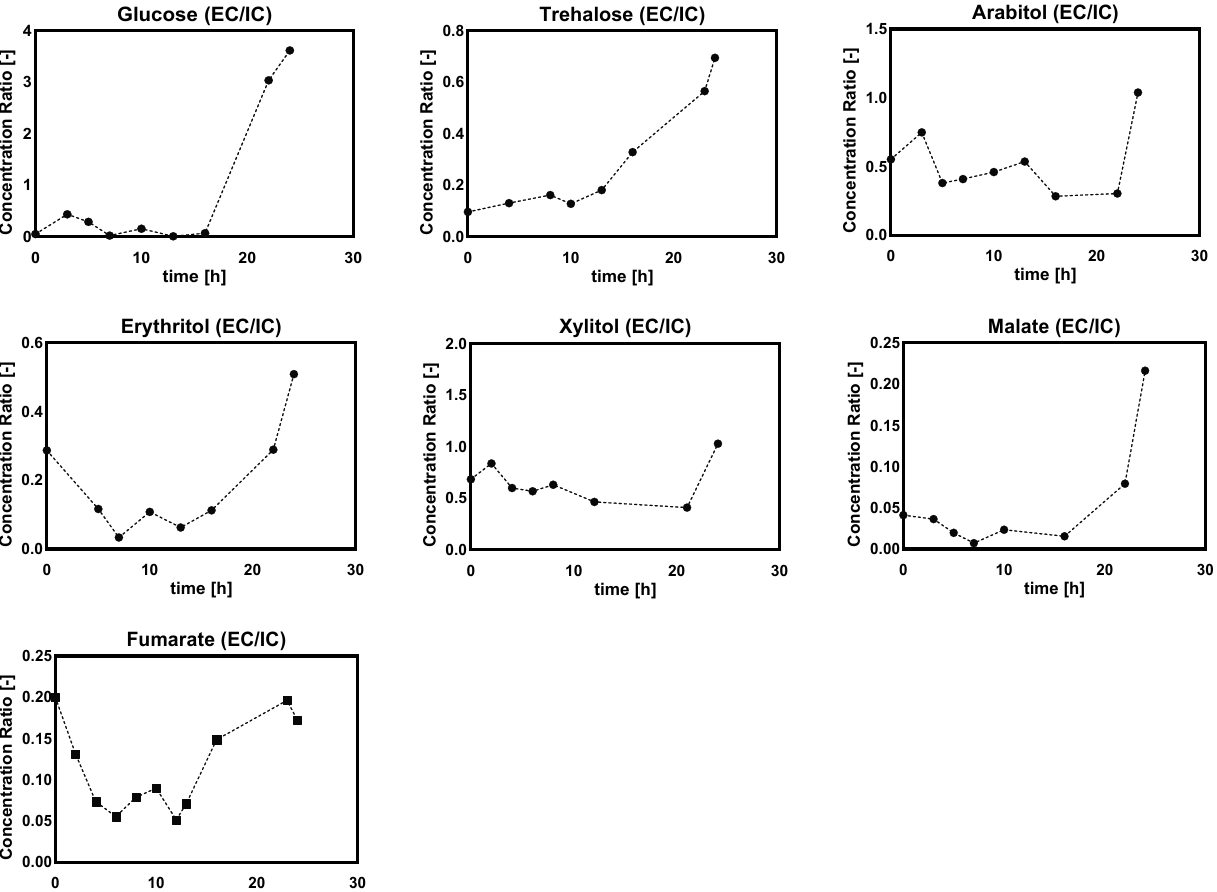
Figure 17. The ratio of extra/intracellular (EC/IC) metabolite concentrations (assuming a cellular volume of 2.5 mL/gDW) in Penicillium chrysogenum Wisconsin 54-1255 under DO ramp-down experi- ments. The dissolved oxygen was linearly decreased from 60% to 0% in 24 h. Time 0 represents the start of DO